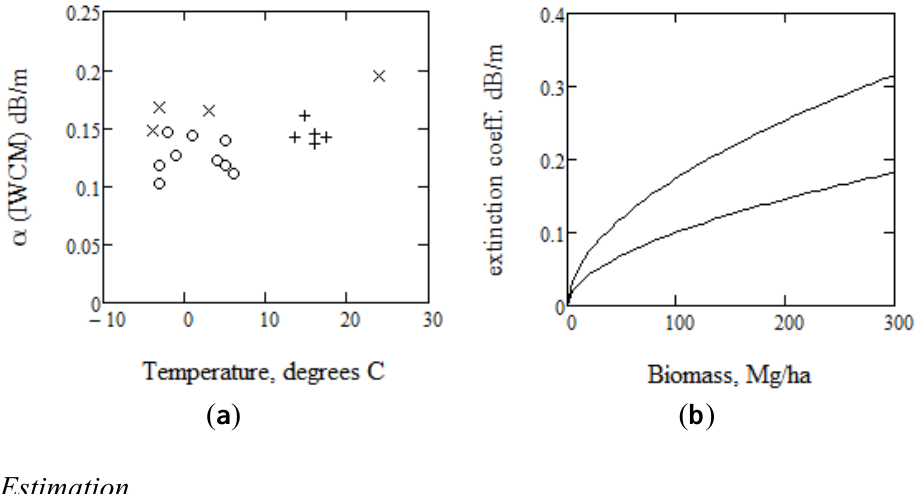
Figure 8. ( a ) Estimates of  in the case of the IWCM with respect to temperature in °C (  for |HOA|  80 m, o for |HOA| ≈ 180 m, and + for |HOA| ≈ 330 m) and ( b ) corresponding range of the extinction coefficient with respect to biomass as delimited by the curves corresponding to the maximum and minimum  (acquisition dates 2011-06-04 and 2012-01-28,